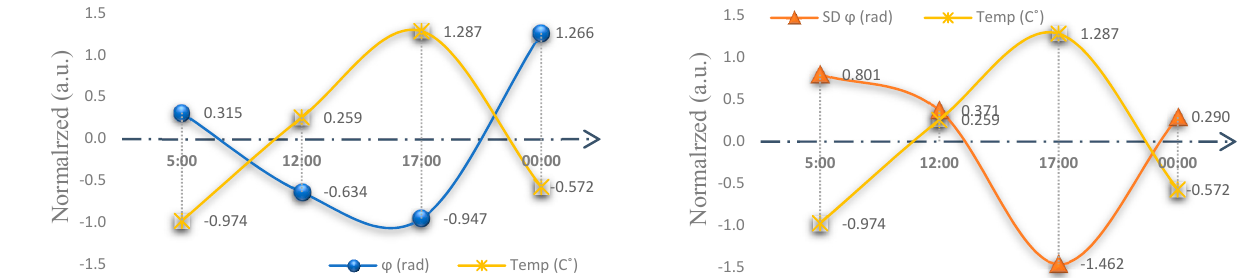
Figure 3. General tendencies in the normal condition: Normalized = standard score (Z calculation); a.u. = arbitrary unit; φ ave − φ 0 = fixed-point shift; SD φ = variability as a function of the frequency